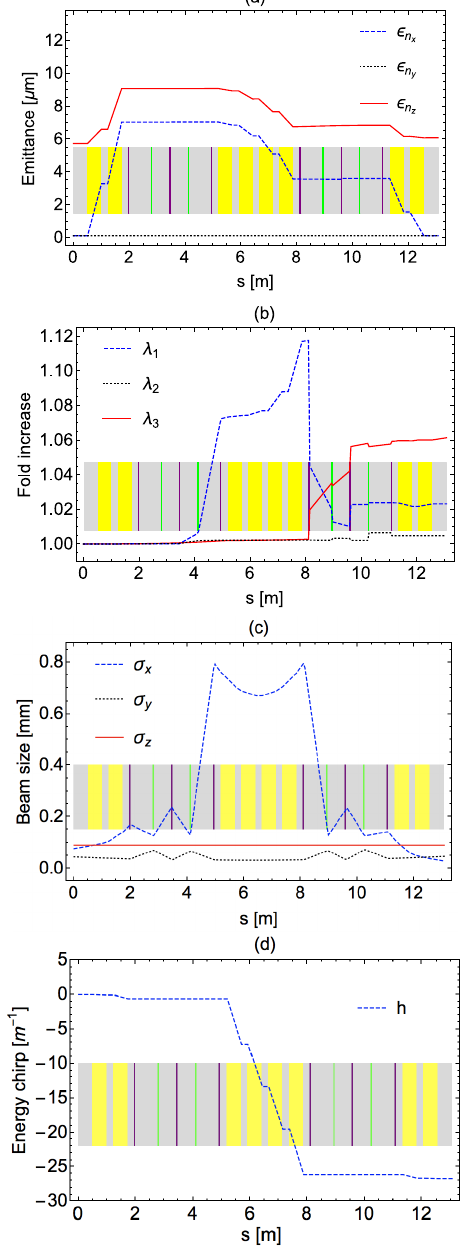
FIG. 12. Evolution of the normalized emittances (a), corre- sponding eigenemittances (b), rms beam sizes (c), and energy chirp (d) along the beam line of the TCAV-based dechirper at 250